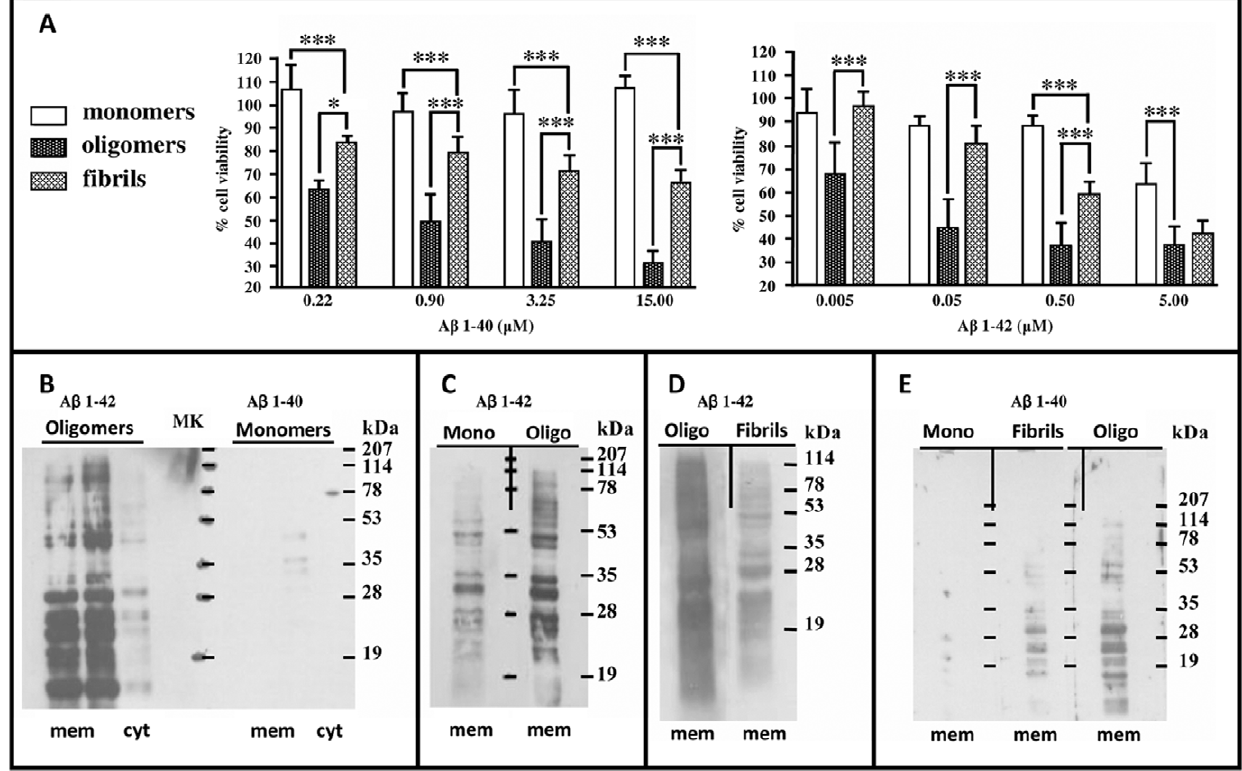
Figure 3. A b toxicity and Far Western Blot assays. A) N2a cell viability after treatment with A b 1–40 species or A b 1–42 species, concentration range from 0.22 m M to 10 m M and 50 nM to 5 m M respectively. ANOVA followed by Bonferroni’s post hoc test; *** p , 0.001; * p , 0.05; p . 0.05 not significant (ns). Mean and SD; N=3 or more different experiments, 4 replicates each. B-C-D-E) Comparisons of binding capacities among different peptide preparations. Fifteen m g proteins from cytosolic (cyt) and membrane fractions (mem) were run on SDS-PAGE and blotted onto nitrocellulose. Far Western Blot was performed with B 1) 100 ng/ml A b 1–42 oligomers; B 2) 100 ng/ml A b 1–40 monomers; C 1) 100 ng/ml A b 1–42 monomers; C 2) 100 ng/ml A b 1–42 oligomers; D1) 100 ng/ml A b 1–42 oligomers; D2) 100 ng/ml A b 1–42 fibrils; E1) 1 m g/ml A b 1–40 monomers; E2) 1 m g/ml A b 1– 40 fibrils; E3) 1 m g/ml A b 1–40 oligomers. Membranes were incubated with peptide solutions separately; then pooled to be stained concurrently with the same antibody incubations and the same film